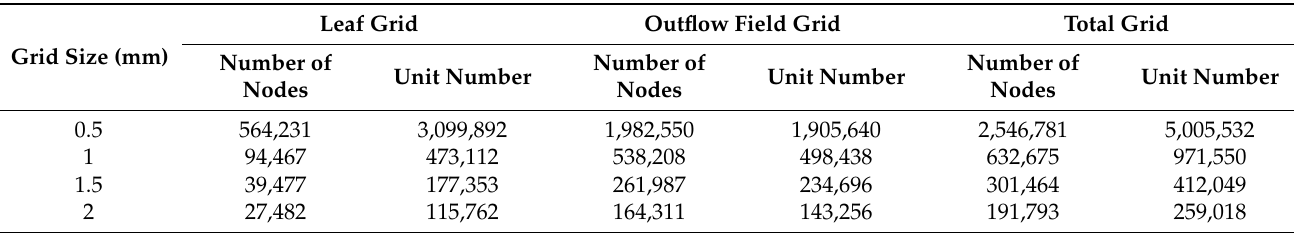
Table 2. Grid division